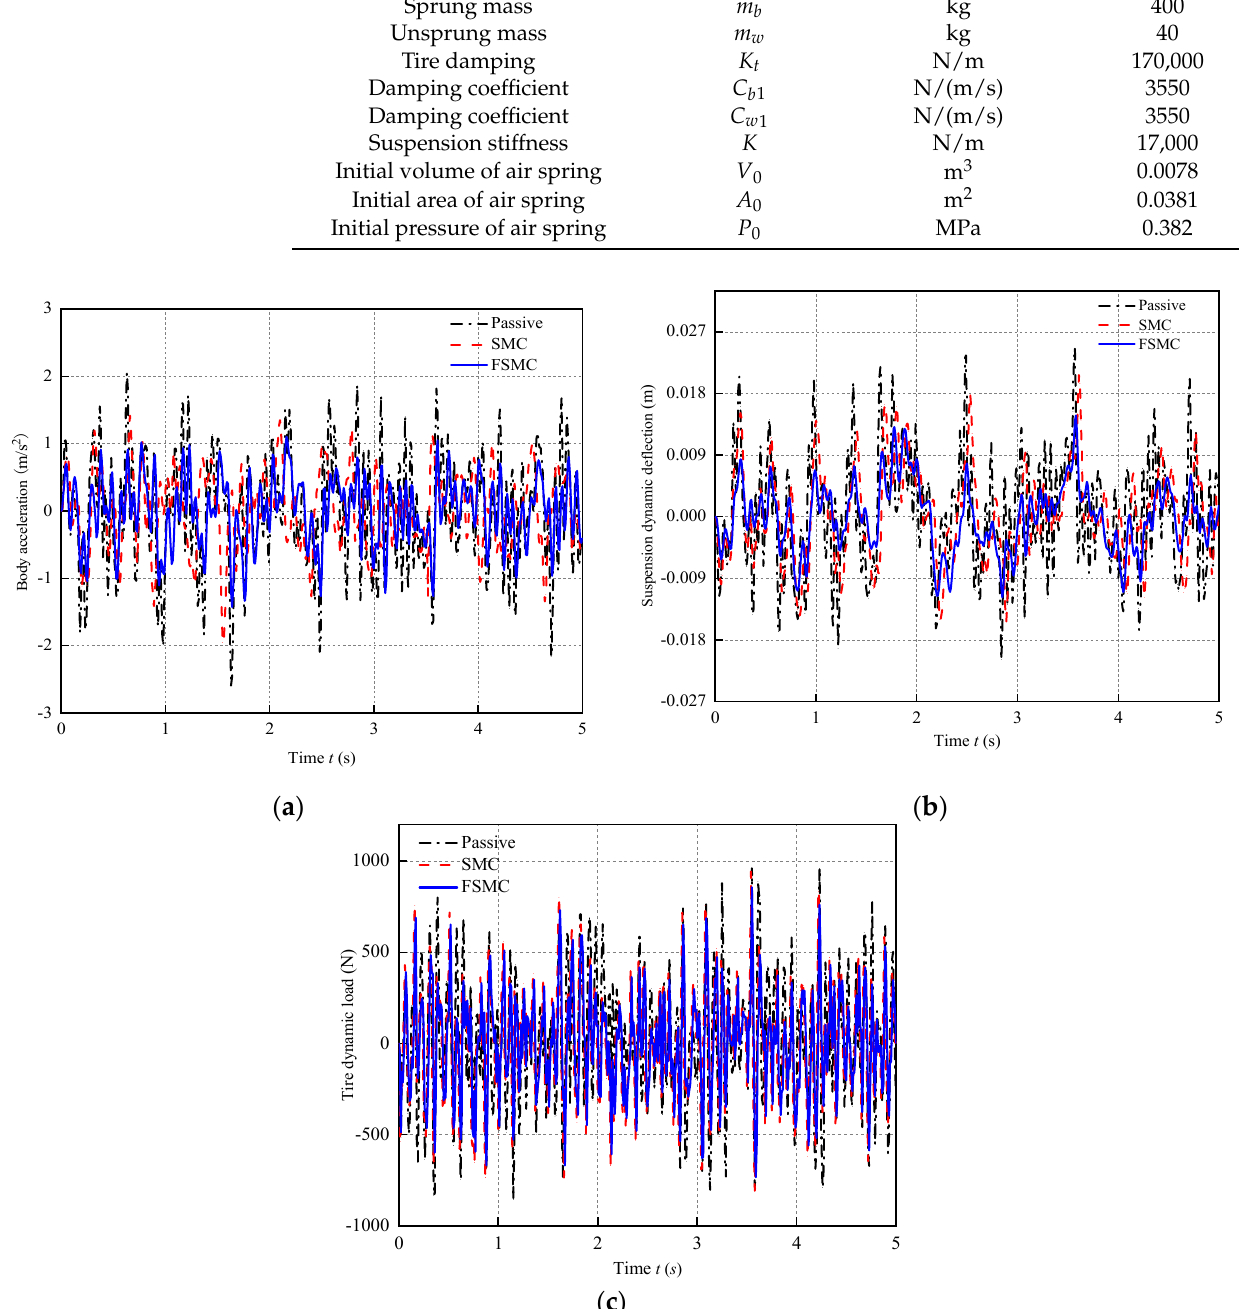
Figure 17. Time domain simulation curve of air suspension system under random road excitation. ( a ) Body acceleration, ( b ) suspension dynamic deflection, ( c ) tire dynamic load.